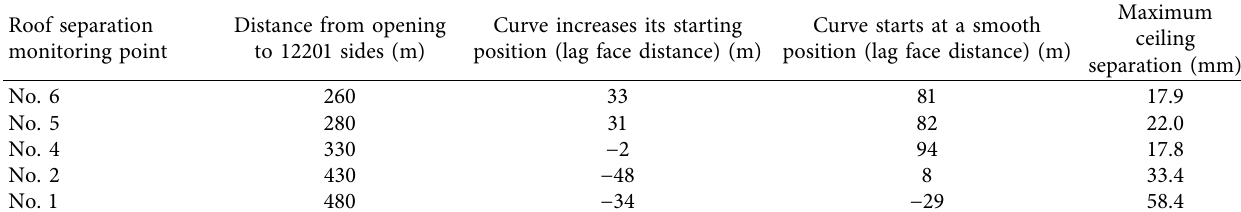
Table 5: Key positions and maximum value on the roof separation variation curve. Roof